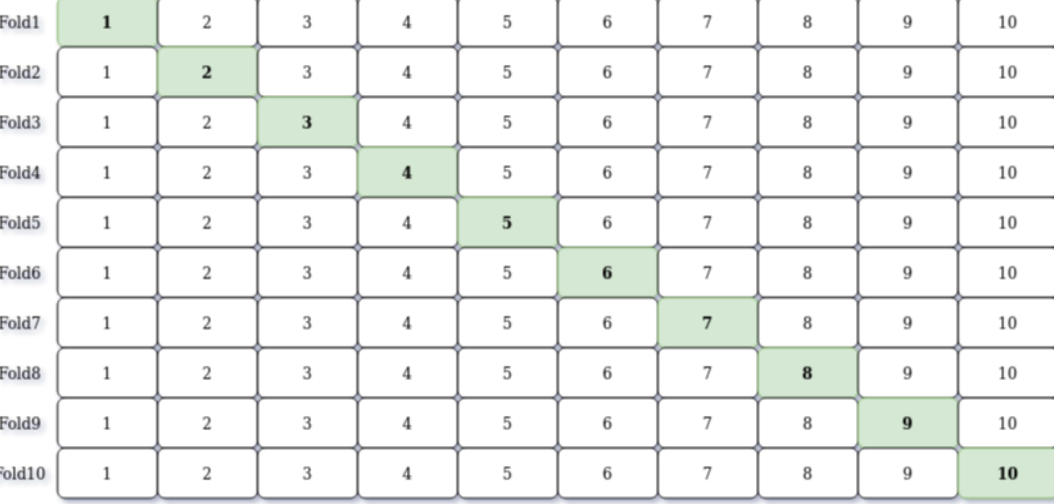
Figure 9. Visualization of 10 Fold Cross Validation. Firstly, the dataset is shuffled and then divided into 10 equal pieces. For each fold, one piece is reserved for testing while the remaining ones are used for training. In this figure, the green pieces indicate those reserved for testing while the white ones belong to those used for training. Thus, each fold has different test